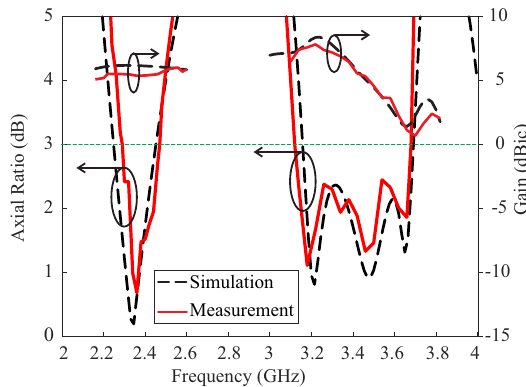
Figure 9. Measured and simulated axial ratios and left-handed circular polarization (LHCP) gains of the proposed antenna.